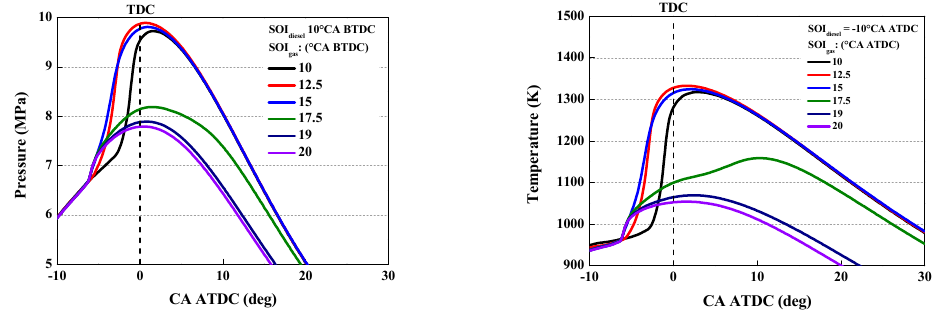
Figure 14. Variation of in-cylinder average pressure ( a ) and temperature ( b ) with NG injection timing.